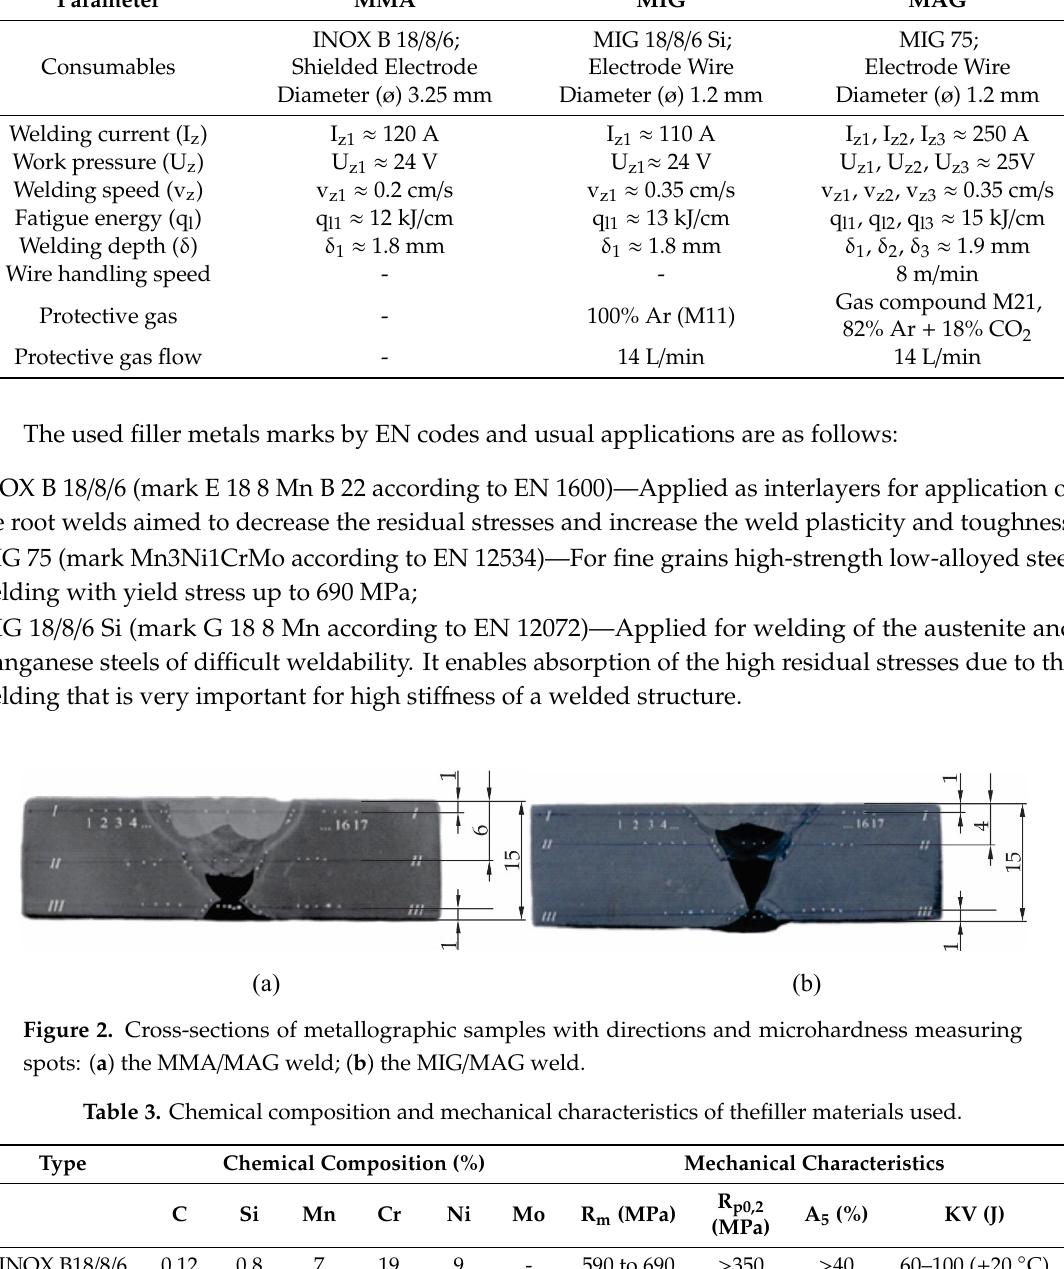
Table 2. Welding parameters and related consumables.